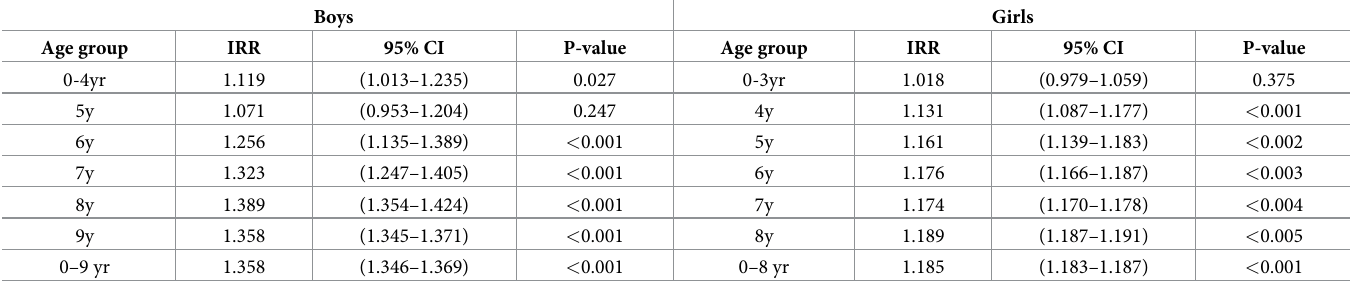
Table 2. The estimated change of central precocious puberty incidence rates per year (IRR and 95% CI) between 2008 and 2020 based on sex and age